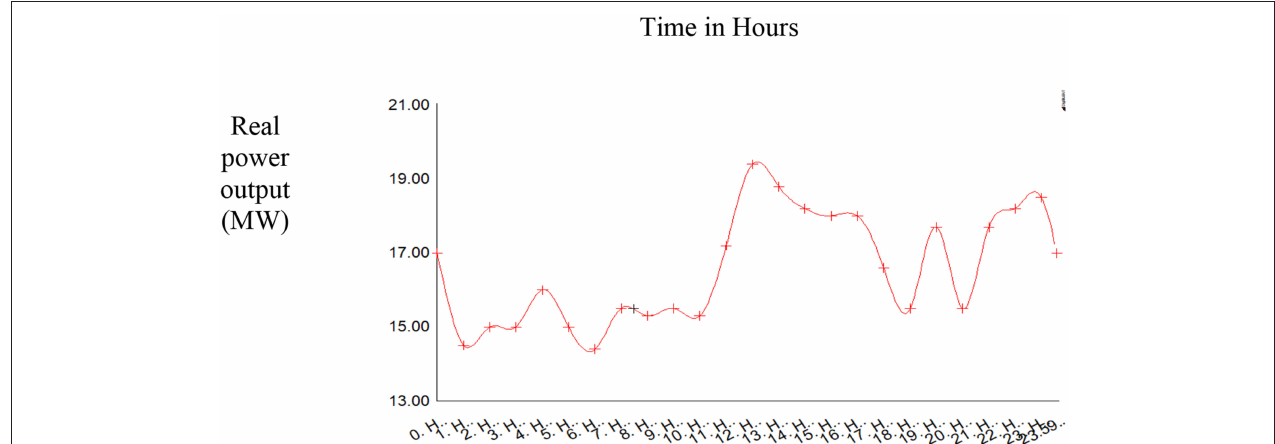
FIGURE 1 | Generation